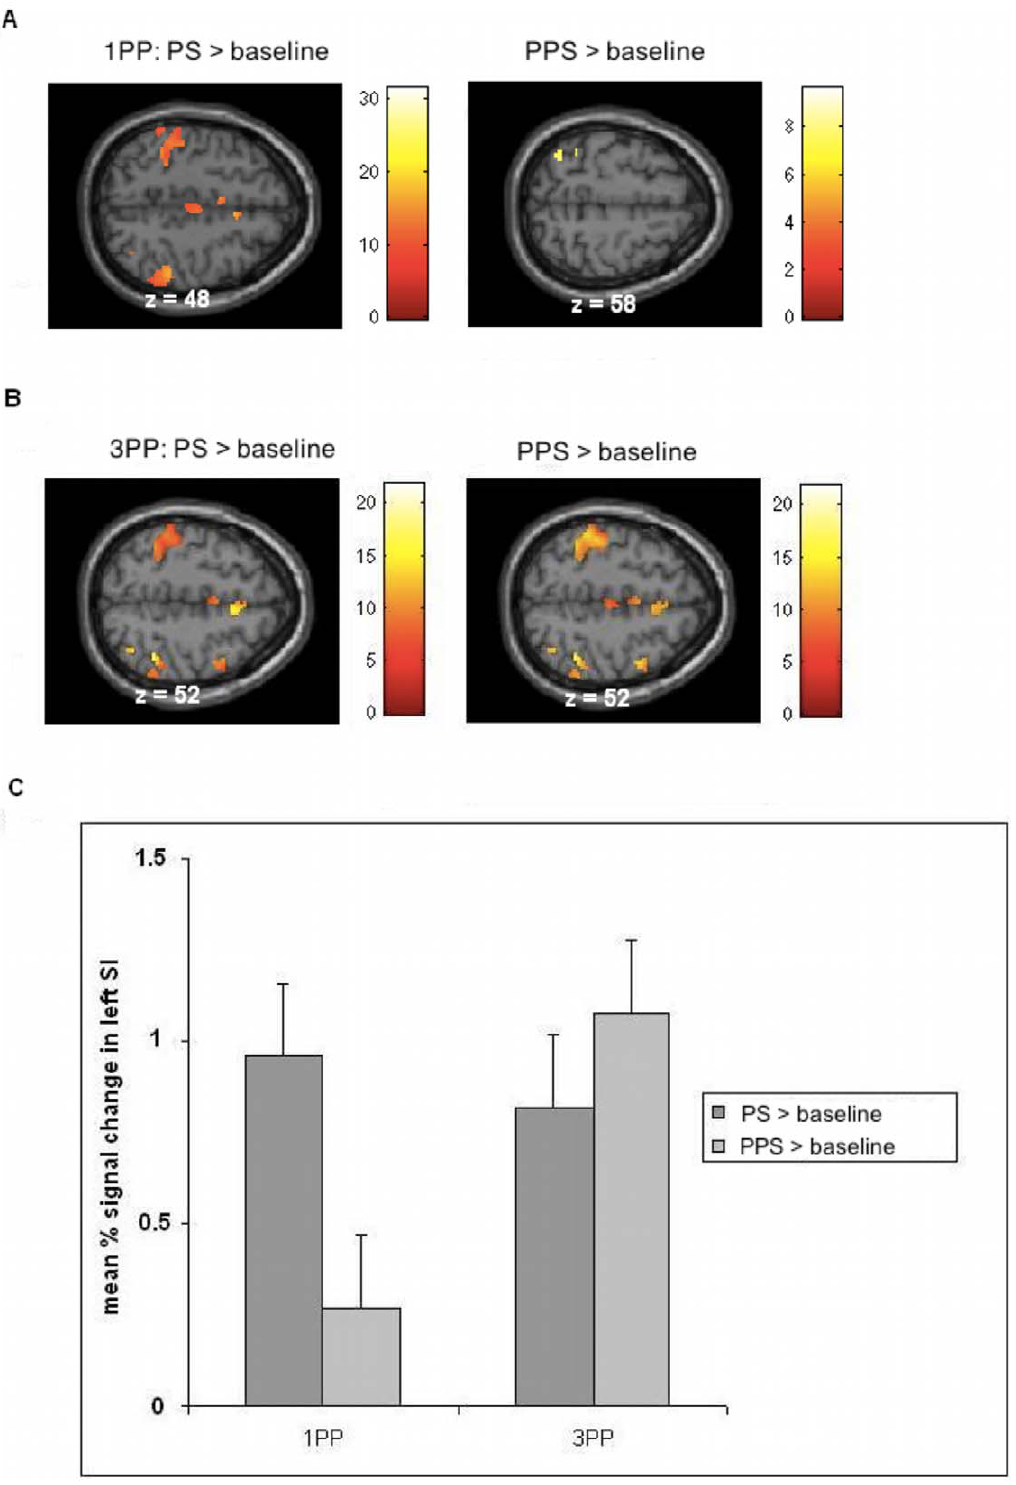
Figure 3. Brain responses in SI while subjects observe touch to a hand and movements close to a hand (=PS and PPS) relative to baseline. A: Results for 1PP revealed activation in left SI for PS events. For PPS events results yielded only minor activation in SI. B: Results for 3PP depict activations in bilateral SI both for PS and PPS conditions. C: Contrast of parameter estimates for activations in left SI (MNI coordinates: 2 38 2 40 52) during PS and PPS conditions relative to baseline. The left two bars show the results for 1PP, the right two bars depict results for 3PP. In the latter, PS as well as PPS events were associated with strong activation in SI, whereas the observation of PPS events revealed even higher activation than the PS condition. The data of the right SI (3PP only) were similar. All results were at p , 0.05, FWE corrected, and masked with real touch relative to baseline in order to reveal common activations with somatosensory areas. doi:10.1371/journal.pone.0042308.g003 PLOS ONE |